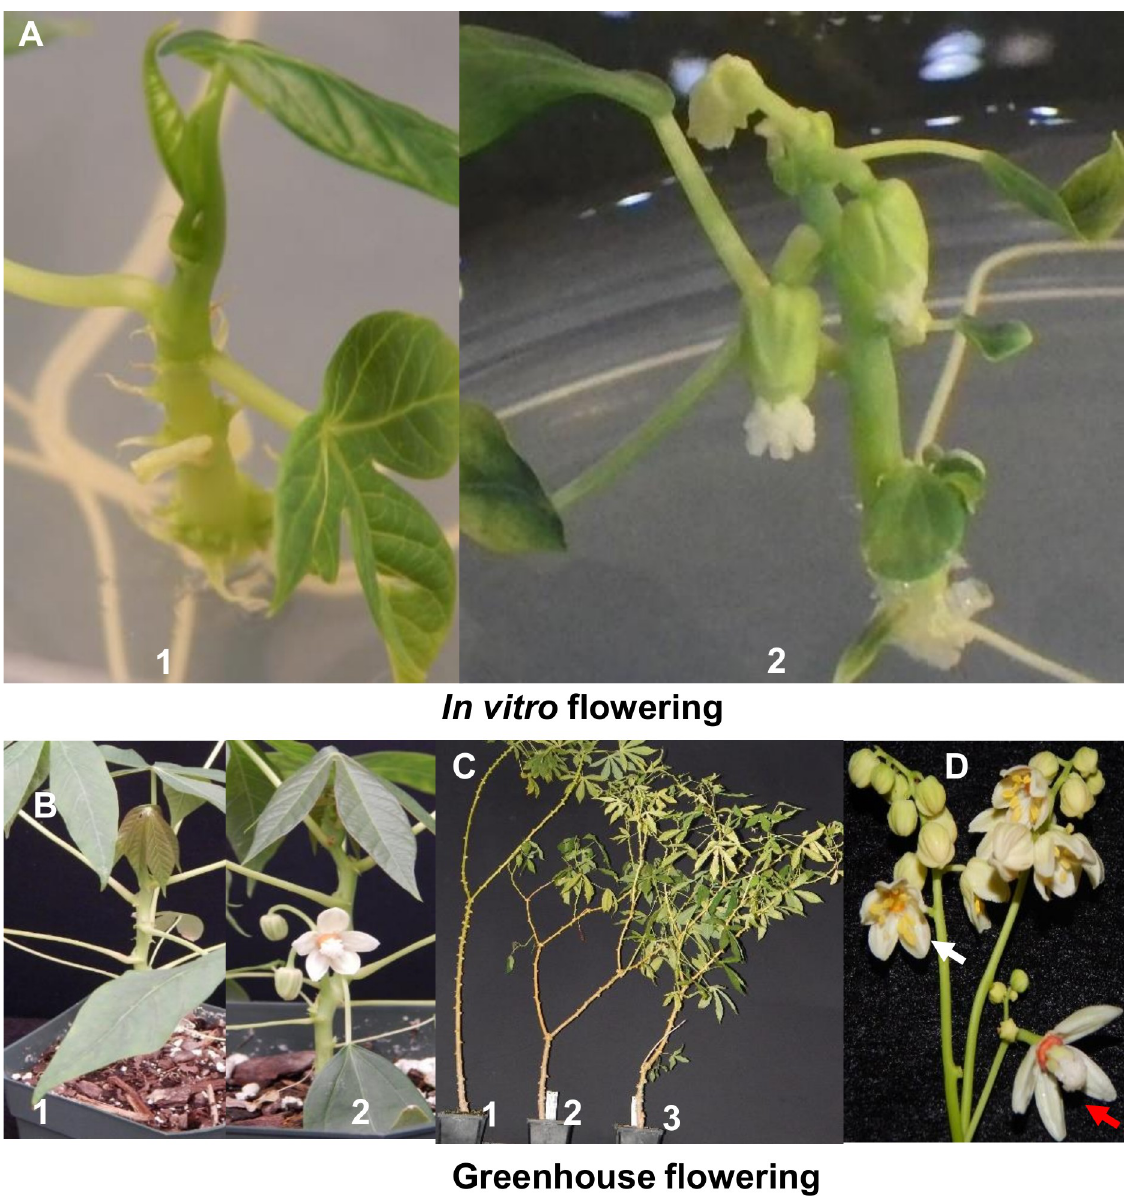
Fig 2. Flowering in transgenic 60444 plants expressing MeFT1 under in vitro and greenhouse conditions. ( A )Transgenic plant line MeFT1-2 flowering in vitro while growing on MS-based medium (A-2). ( B ) MeFT1-1 plant line flowering 14 days after transfer to soil (C-2). Non-flowering plants are non-transgenic controls regenerated from somatic embryos (left) (A-1, C-2). ( C ) Branching phenotype in repetitively flowering transgenic plant lines (C-2, C-3) compared to control 180 days after planting (C-1). ( D ) Inflorescence produced from stake derived plant line MeFT1-1 showing numerous male flowers above opened female flowers (red arrow) 90 DAP, white arrow indicates open male flower about 20 days after emergence in transgenic plant line MeFT1-2.